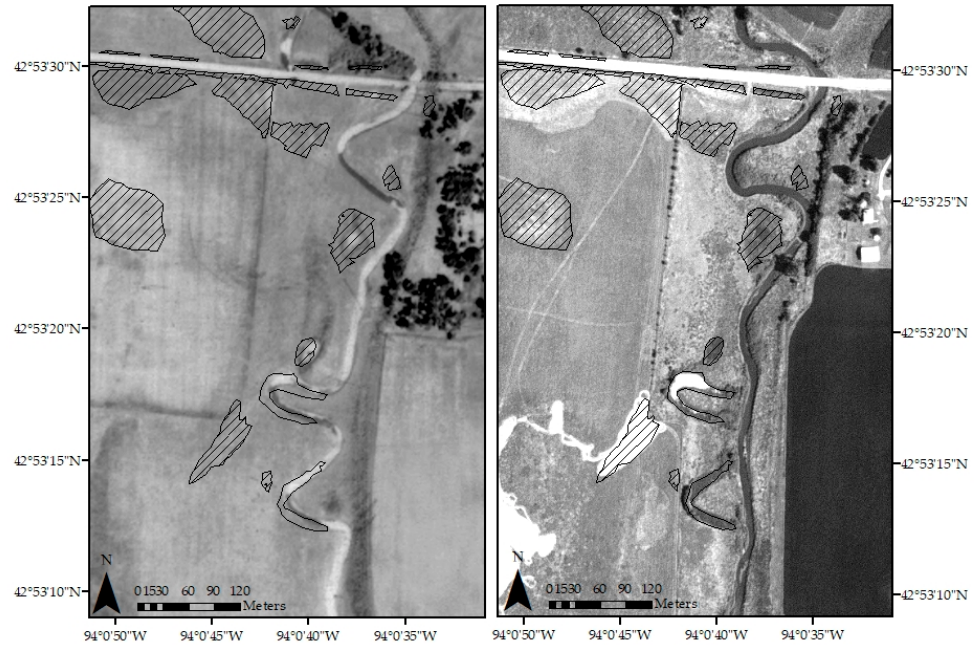
Figure 2. Target (unfilled) and Non-Target (hatched) features identified using ( Left ) historical 1930s aerial imagery; ( Right ) 2015 aerial imagery. Table 2. The initial number of depressions identified within 500 m buffer of perennial streams by watersheds. The depressions that had <100 m 2 area outside an agricultural field and depressions that intersect the stream were excluded from